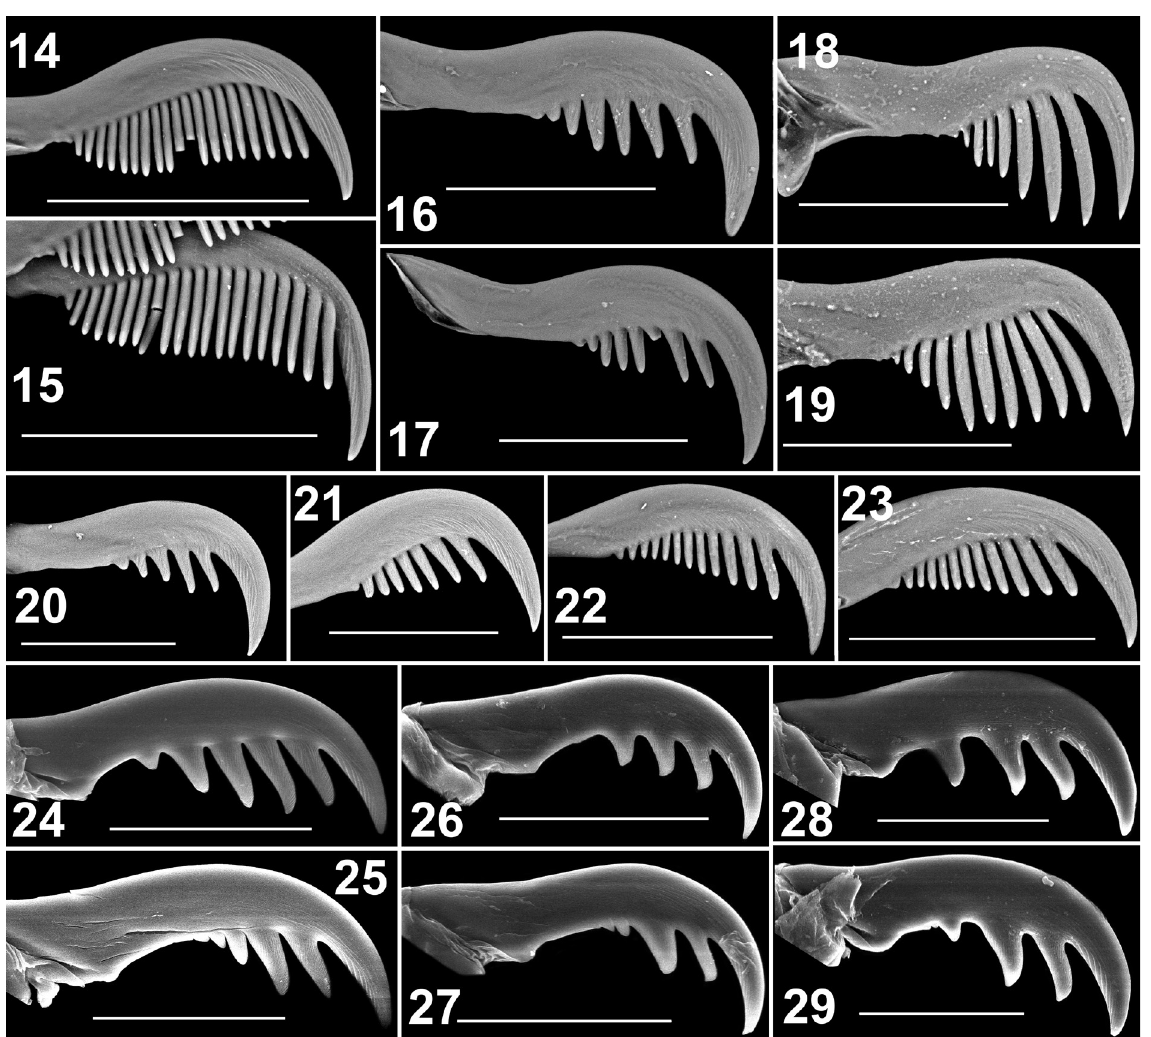
Figs 14–29. Tarsal claws of legs 1 in females of Stenaelurillus Simon, 1886, scanning electron micrographs. 14–15 . S. nigricaudus Simon, 1886. 14 . Retrolateral. 15 . Prolateral. 16–17 . S. guttatus ( Wesołowska & Cumming, 2002) comb. nov. 16 . Retrolateral. 17 . Prolateral. 18–19 . S. termitophagus ( Wesołowska & Cumming, 1999) comb. nov. 18 . Retrolateral. 19 . Prolateral. 20–21 . S. fuscatus Wesołowska & Russell-Smith, 2000. 20 . Retrolateral. 21 . Prolateral. 22–23 . S. guttiger (Simon, 1901). 22 . Retrolateral. 23 . Prolateral. 24–25 . Aelurillus v-insignitus (Clerck, 1757). 24 . Retrolateral. 25 . Prolateral. 26–27 . Phlegra fasciata (Hahn, 1826). 26 . Retrolateral. 27 . Prolateral. 28–29 . Langona bristowei Berland & Millot, 1941. 28 . Retrolateral. 29 . Prolateral. Scale bars: 0.1